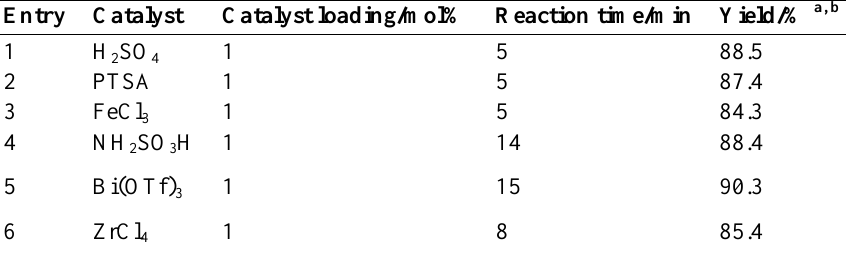
Table 2. Comparison of different